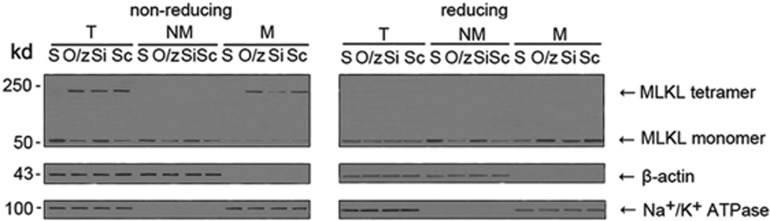
MLKL oligomerization is enhanced in the membrane fraction of the OPCs after OGD/zVAD insult. OPCs were subjected to OGD/zVAD. Total, non-membrane, and membrane fractions were then resolved on either reducing or non-reducing gels and analyzed by western blotting. MLKL was largely in the non-membrane fraction as monomers (~50 kDa) under normal culture conditions, but formed an oligomer larger than 250 kDa in the membrane fraction in OPCs 12 h after OGD/zVAD. siRNA-mediated RIPK3 inhibition attenuated the oligomerization of MLKL in the OPCs membrane fraction in the OGD/zVAD group 12 h after OGD. The absence of Na+-K+-ATPase in the non-membrane fraction indicated that there was no cross-contamination between the non-membrane and membrane fractions. T, total cell lysate; NM, non-membrane fraction; M, membrane fraction; S: sham; O/z: OGD/zVAD; Si: RIPK3 siRNA; Sc: RIPK3 siRNA scramble